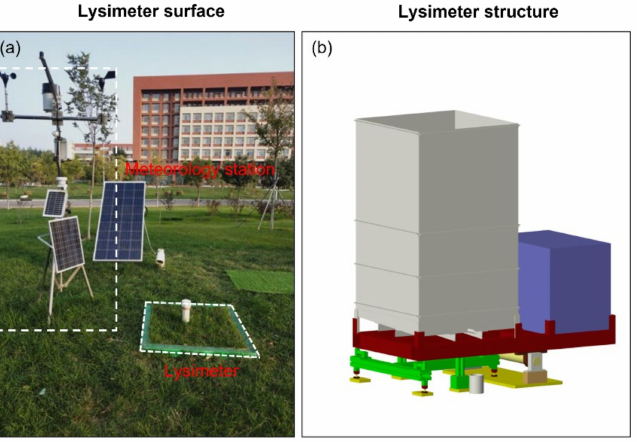
Figure 2. Above-ground part and underground part of turf field experiment. (( a ) represents the above-ground part of the lysimeter; ( b ) represents the structure diagram of the